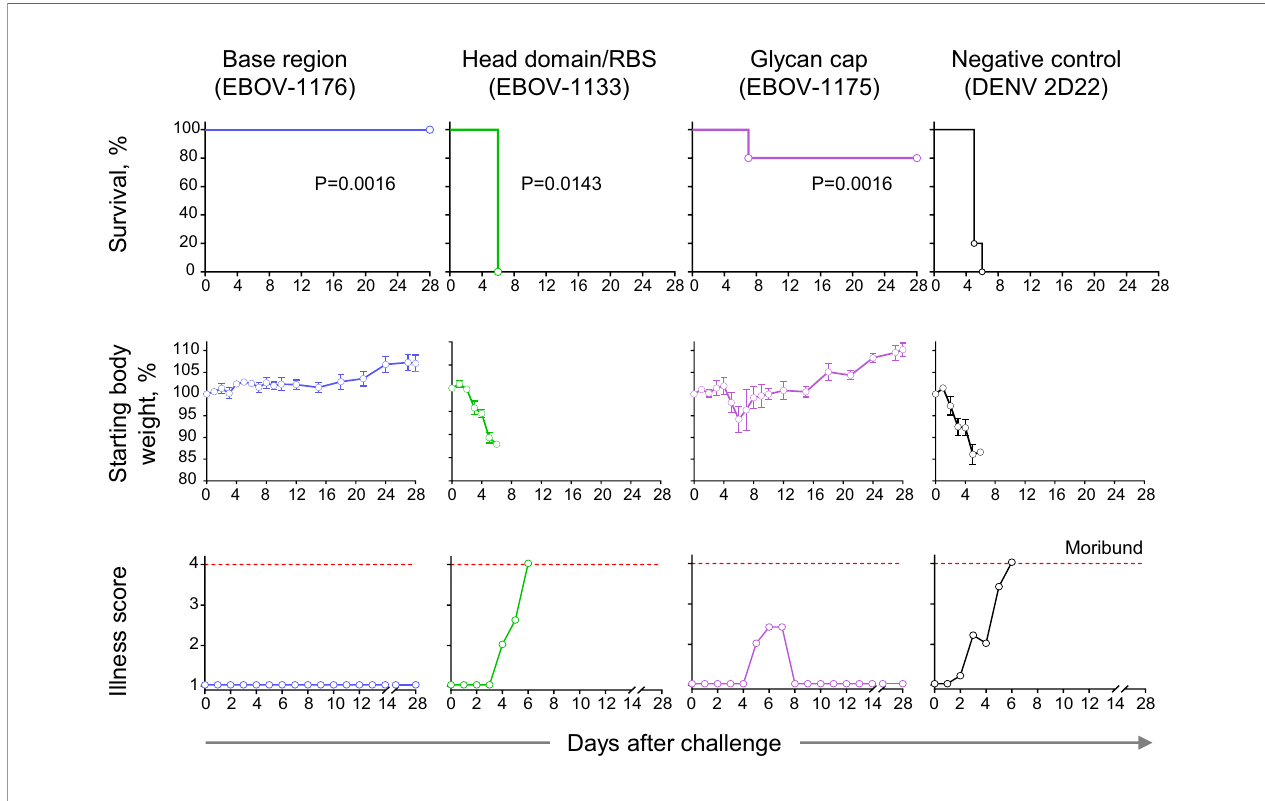
FIGURE 7 | Therapeutic protection by class-representative plasma antibodies in mice. In vivo therapeutic protection by individual antibodies. C57BL/6 mice (n = 5 per group) were challenged with mouse-adapted EBOV-MA, treated at 1 day after virus inoculation with indicated antibody at a dose of 3.75 mg/kg, and monitored for 28 days. Dengue virus human antibody DENV 2D22 served as a control. Survival curves (top panel) were estimated using the Kaplan-Meier method, and each treatment group was compared to the DENV 2D22 group using a two-sided log-rank (Mantel – Cox) test. P-values are indicated for each comparison, and Bonferroni-corrected threshold for signi fi cance level was set up to P = 0.017. Weight change (middle panel) and illness score (bottom panel) are shown. Data represent one